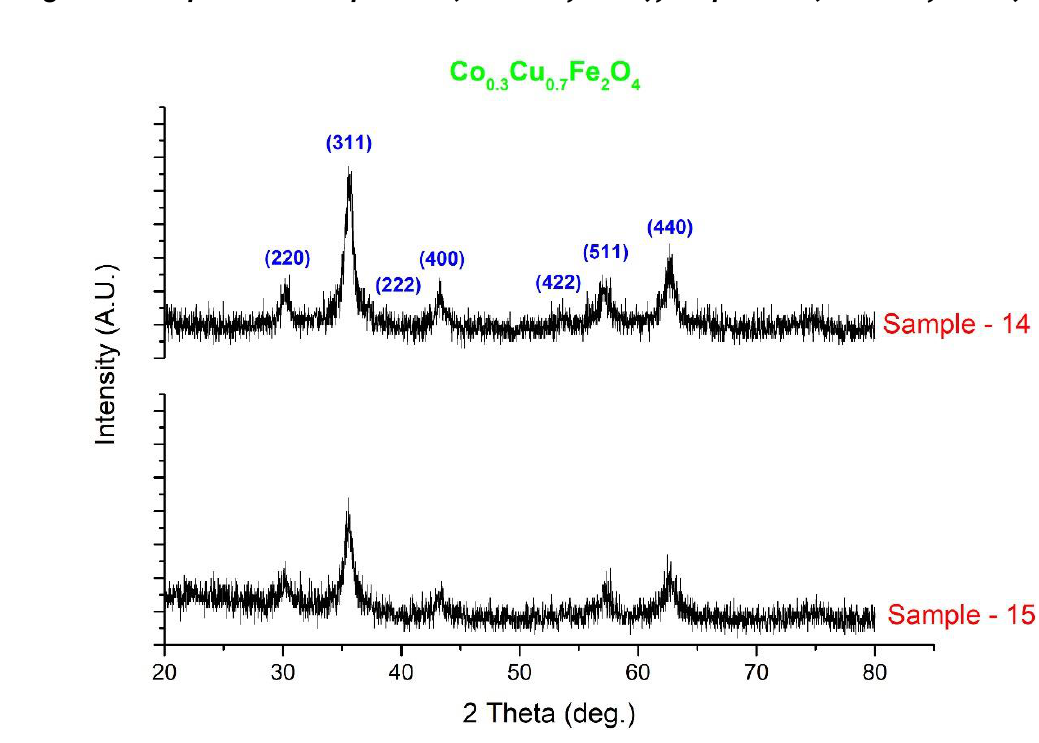
Fig.5-II: XRD pattern of sample – 12 (T=150 o C, t=10h), sample – 13 (T=150 o C, t= 12h).